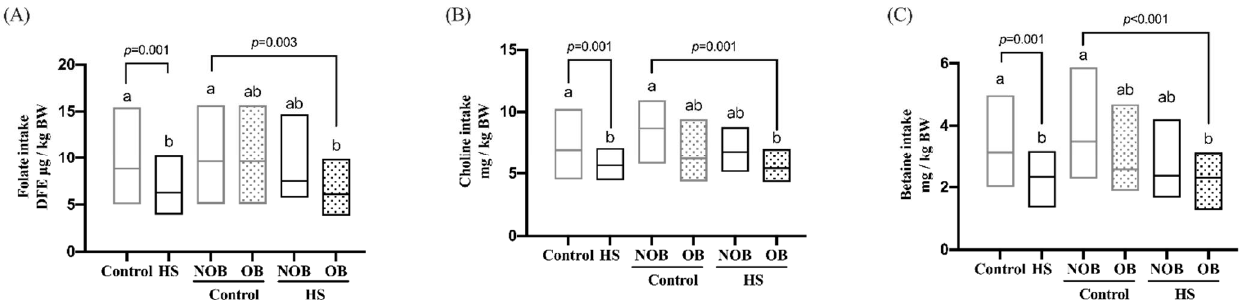
Figure 1. Individual methyl-donor nutrients (MDNs) intake of the HS and obesity (OB)-stratified participants. The habitual intake of folate ( A ), choline ( B ) and betaine ( C ) in the HS and OB-stratified subjects was assessed by quantitative food frequency questionnaire (qFFQ). OB was defined by BMI (≥30 kg/m 2 ), waist/hip circumference ratio (men ≥ 0.9 and female ≥ 0.85), or visceral adiposity grade (>10) or percentage body fat (men ≥ 25% and women ≥ 32%). All intakes are expressed as per kg body weight values. The data are presented as medians and interquartile range (25th, 75th). Variables were compared using the non-parametric test of Kruskal–Wallis. Values with different letter differ significantly at p < 0.05. Abbreviations: BW, body weight; DFE, dietary folate equivalent; NOB, non-obesity.